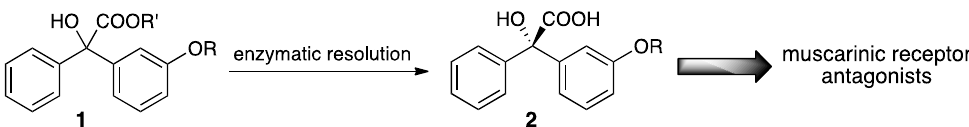
Figure 1. Kinetic resolution of esters of 2,2-diaryl-2-hydroxy acids; optically pure acids are building blocks for the synthesis of muscarinic receptor antagonists.